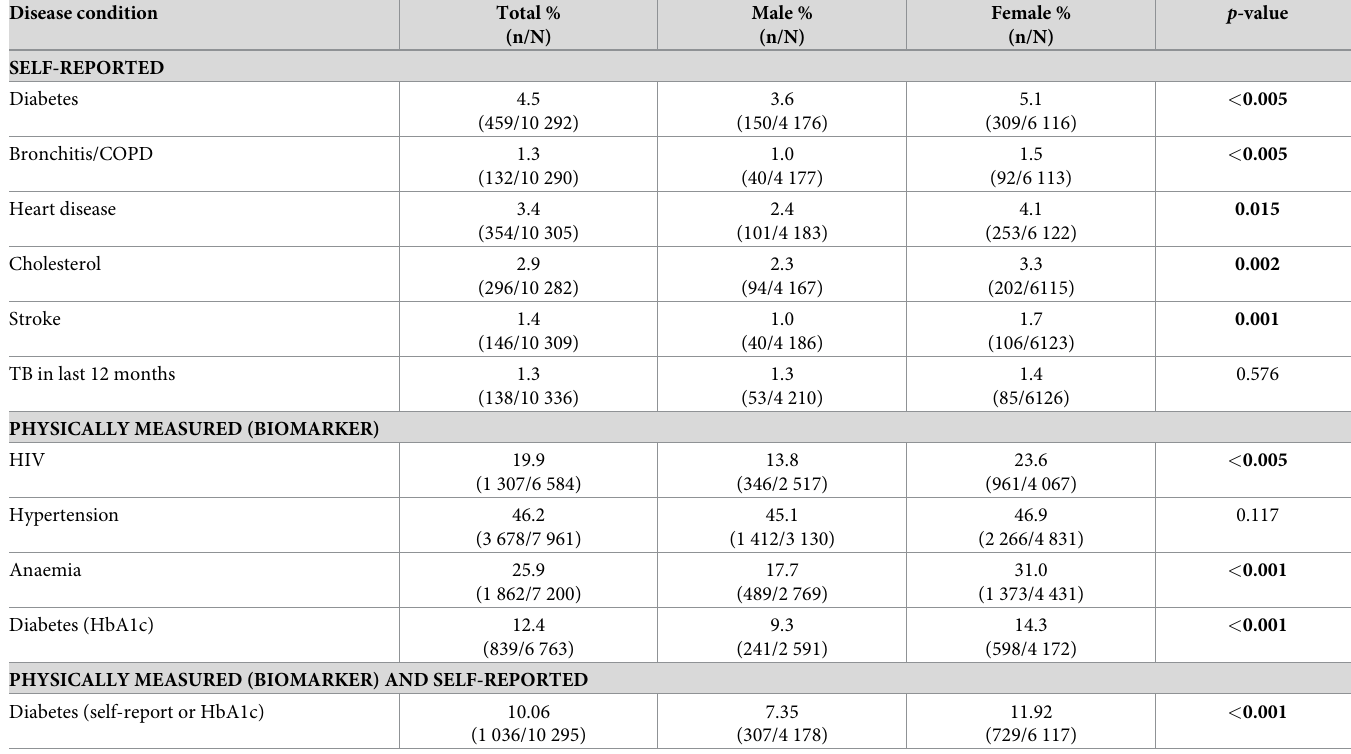
Table 3. Prevalence of single disease conditions by sex and method of measurement in South Africa for 2016 (unweighted data). Disease